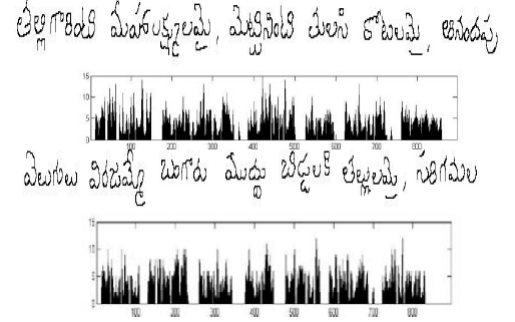
Figure 16. Histogram Projections for telugu text